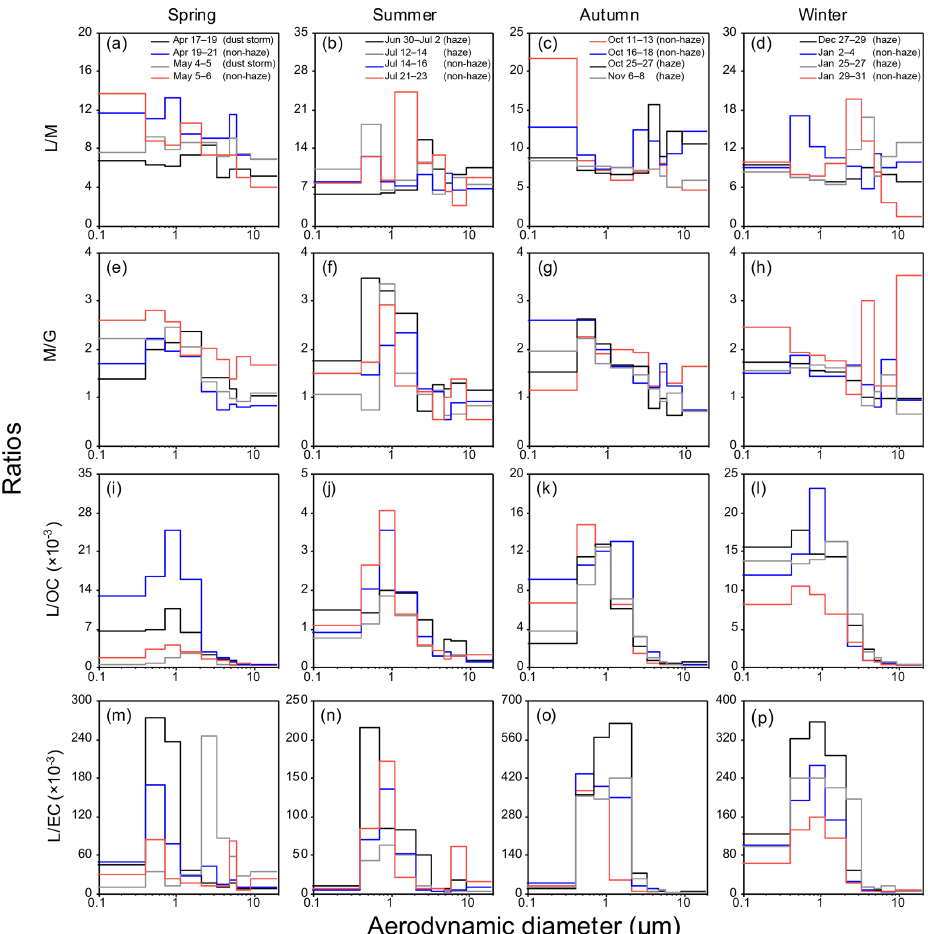
Figure 3. The concentration ratios of L / M, M / G, L / OC and L / EC according to particle size for urban aerosols in Beijing during April 2017 to January